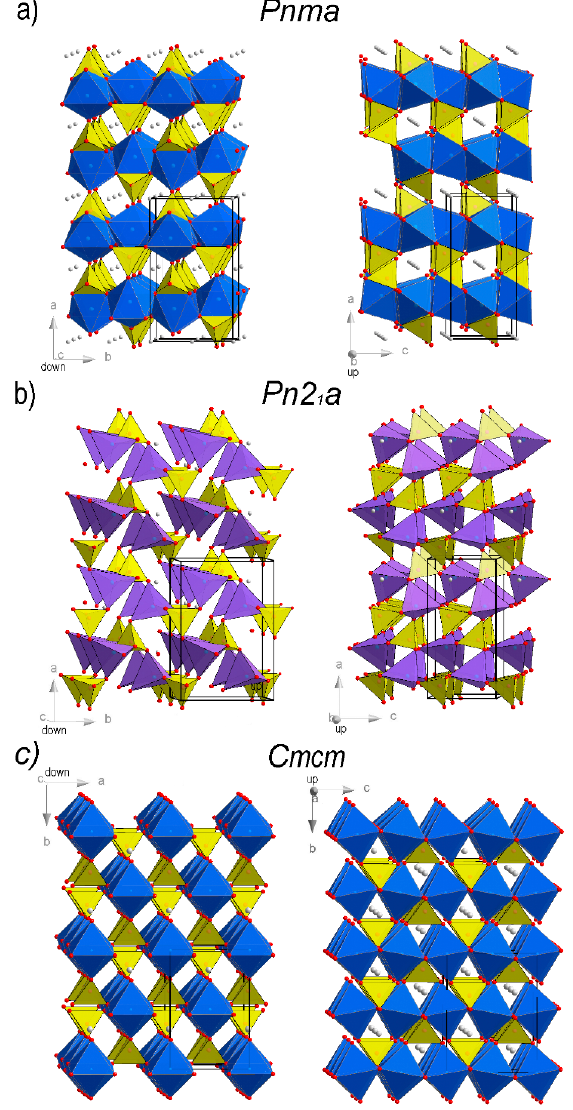
Figure 1. Projections of the crystal structures of the three orthorhombic polymorphs of LiCoPO 4 (LCP) along the crystallographic c and b axes with the space groups: ( a ) P nma ; ( b ) P n 2 1 a ; and ( c ) C mcm . [CoO 6 ] octahedra are drawn in blue, [PO 4 ] tetrahedra in yellow, [CoO 4 ] tetrahedra in purple, Li + ions in grey and O 2 − ions in red.